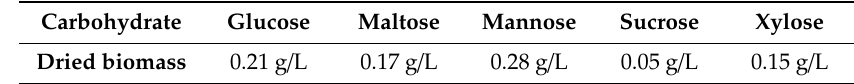
Table 1. Dried biomass concentration for di ff erent culture media containing various carbohydrates (1 g / L) and yeast extract (0.1 g / L).